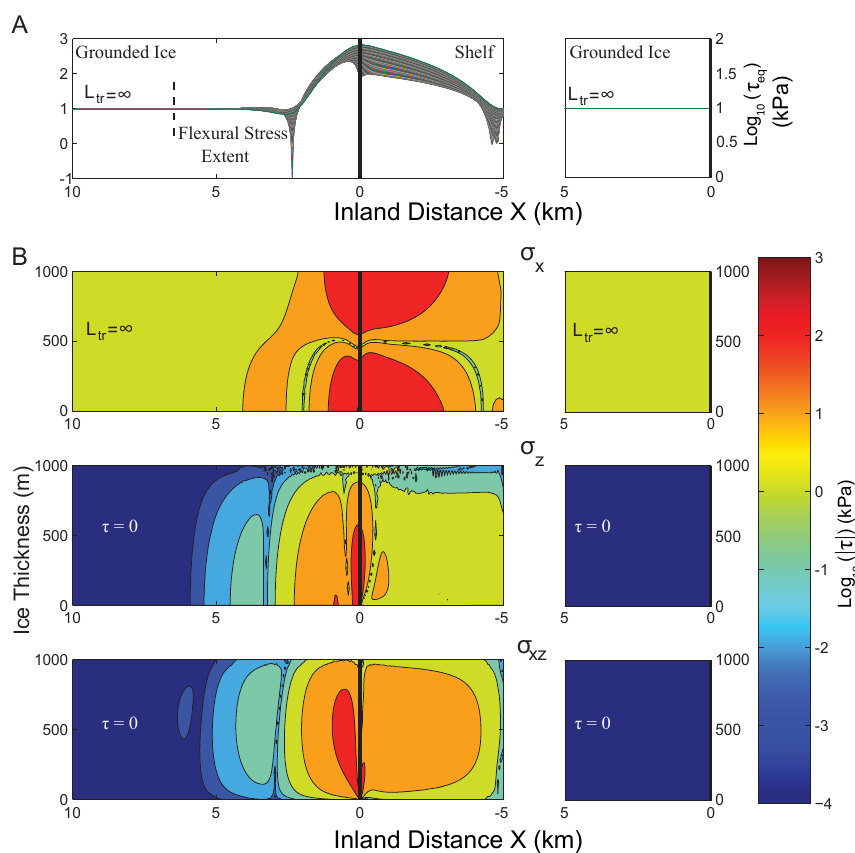
Figure 3. Distributions of stress for a 2-D model with a free-sliding basal condition. (a) shows longitudinal profiles of σ eq at a depth interval of 10m, while (b) shows the logarithm of the absolute value of the three in-plain stress components ( σ x , σ y , and σxy ) for the entire 2-D model domain. Model results are shown including (left panels) and not including (right panels) an ice shelf. In the free-sliding models, axial stress does not decay with distance and flexural stress rapidly decays near the grounding line. L tr is the stress transmission length scale as defined in Sect.